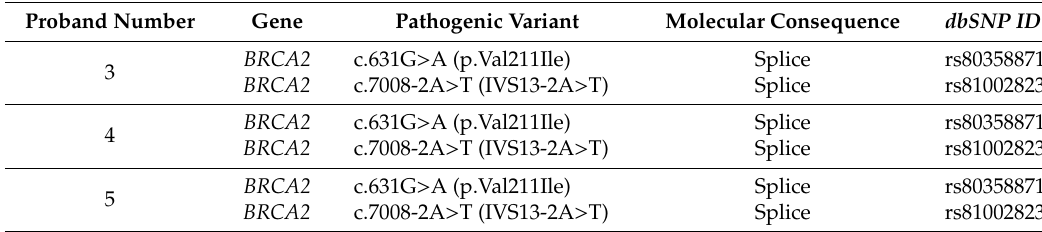
Table 2. Probands with double mutation (DM) in the BRCA2 genes.